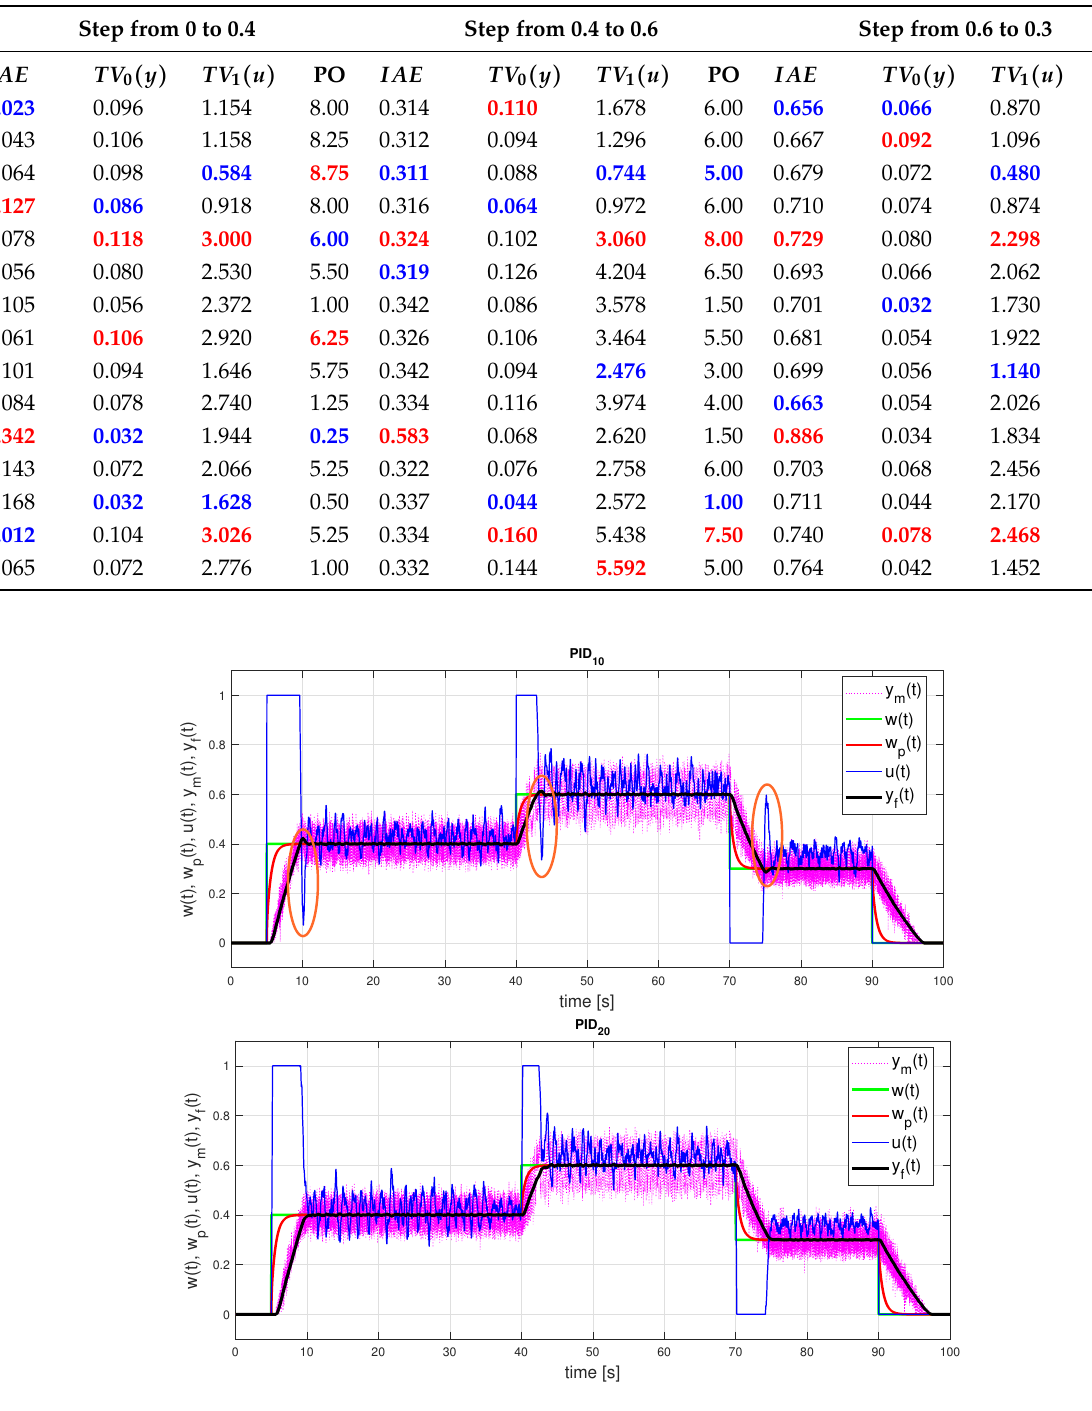
Figure 9. PID control: setpoint responses corresponding to IPDT approximation of an initial part of a normed step response y n ( t ) for both possible sets of the controller parameters (46) with emphasis on areas with overshooting output and with excessive input pulse of PID 10